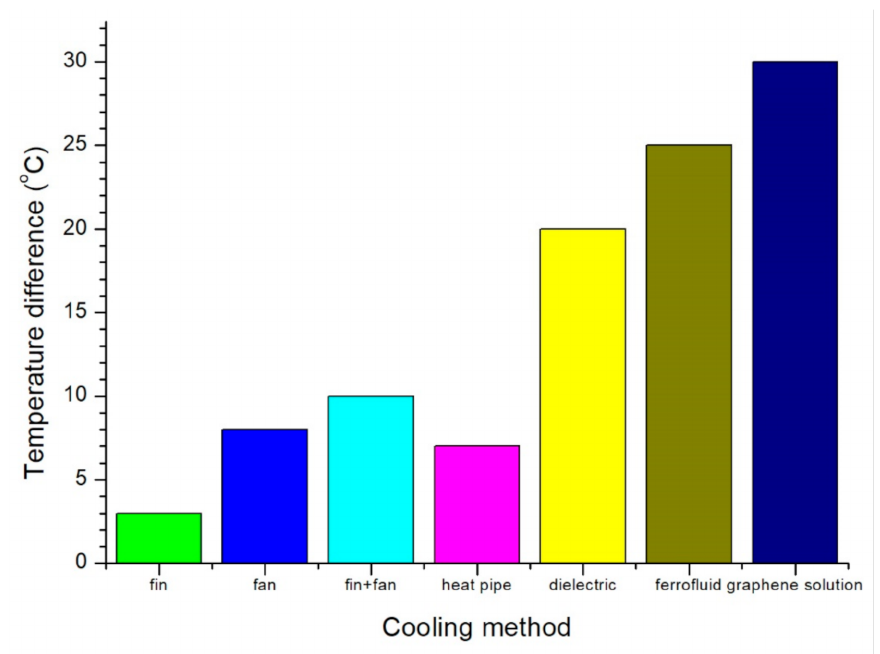
Figure 9. Temperature differences of LED using various cooling